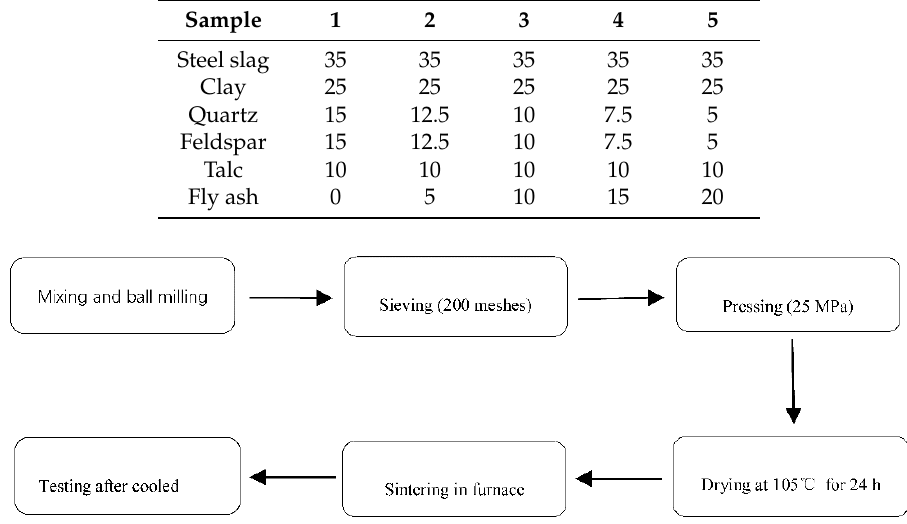
Figure 1. Processing route for the specimens. Table 2. Batch compositions of the samples (wt %).